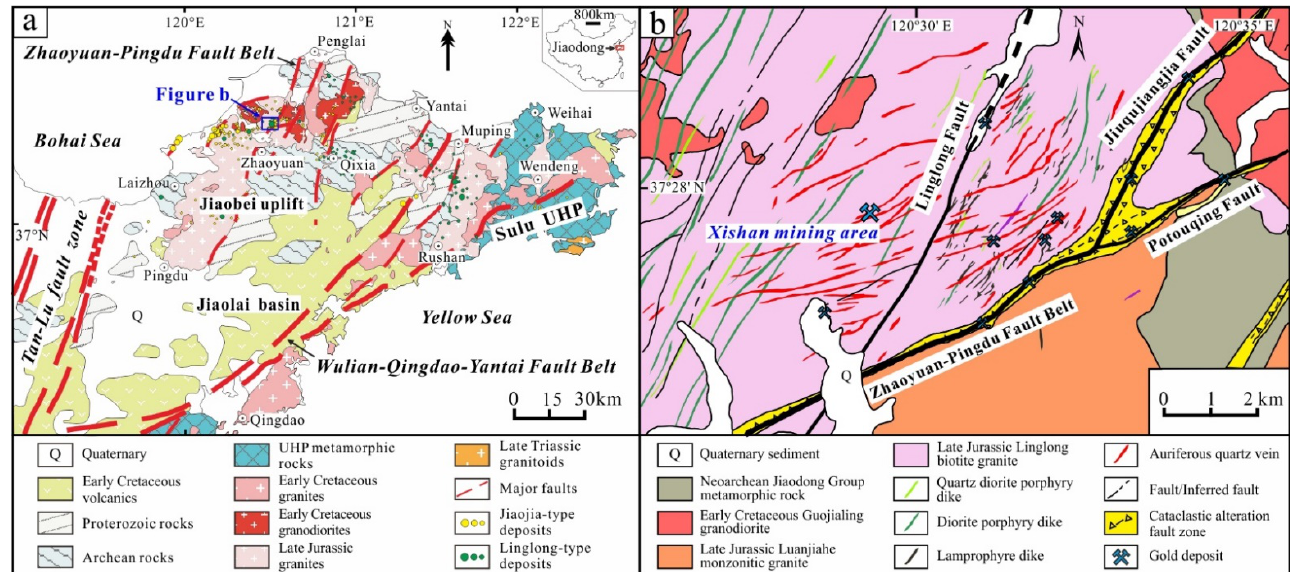
Figure 1. ( a ) Regional geological map of the Jiaodong Peninsula and the distribution of gold deposits (modified after [32]). ( b ) Simplified geological map of the Linglong goldfield (modified after [15]). Samples of this study were collected from the Xishan mining area.